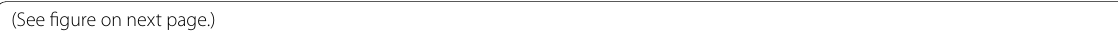
Fig. 2 Functional expression of LOX-1 in the liver. A , B Relative protein expressions of LOX-1 in liver tissue of mice at different time points after transfection in LOX-1 group using western blot analyses. **P < 0.01 compared with the control group. C Detection of LOX-1 expression in liver tissue from mice in control and LOX-1 group (immunohistochemistry, n and LOX-1 group (immunofluorescence, n hepatocytes (laser scanning confocal microscopy, n